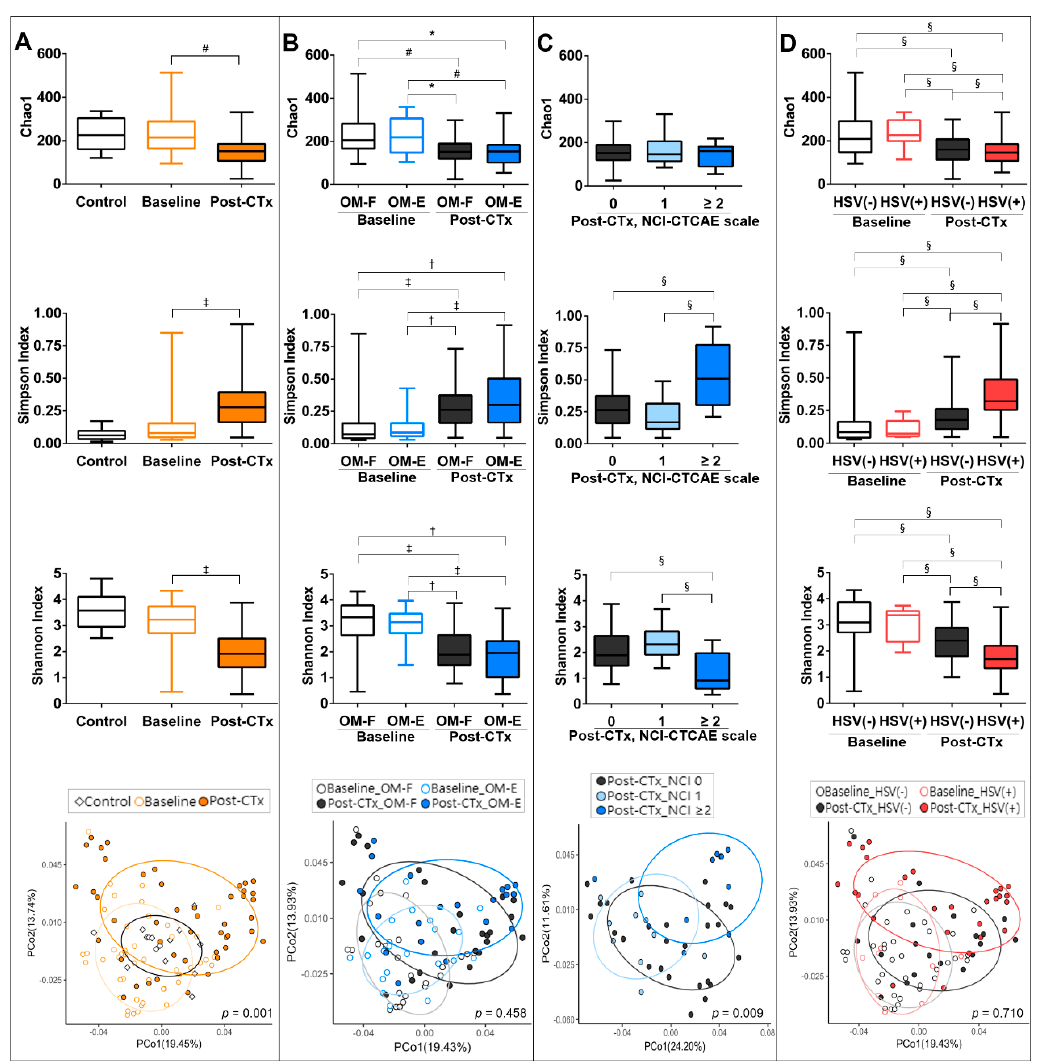
Figure 2. Structures of the mucosal bacterial communities collected from control subjects and patients undergoing autologous HSCT at baseline and post-chemotherapy (post-CTx). Bacterial communities were analyzed by high-throughput sequencing of the bacterial 16S rRNA gene. The species richness, evenness, and diversity were estimated by the Chao1, Simpson, and Shannon indexes, respectively (Top three panels). A PCoA plot was generated using the weighted UniFrac metric with normalization for read counts (bottom-most panel). ( A ) The communities of control subjects and the baseline and post-chemotherapy communities of patients were compared. ( B ) The baseline and post-chemotherapy communities of patients who were free of OM (OM-F) and those of patients who experienced OM (OM-E) defined as the NCI-CTCAE grade > 0 during autologous HSCT were compared. ( C ) The post-chemotherapy communities of patients were compared by the NCI-CTCAE scale. ( D ) The baseline and post-chemotherapy communities of patients without or with HSV-1 detection were compared. *, p < 0.05 by non-paired t-test; #, p < 0.05 by paired t-test; †, p < 0.05 by the Mann–Whitney U test; ‡, p < 0.05 by the Wilcoxon signed-rank test; §, p < 0.05 by the Kruskal–Wallis test followed by post-hoc with the Bonferroni method. The p values in the PCoA plots were obtained by PERMANOVA.